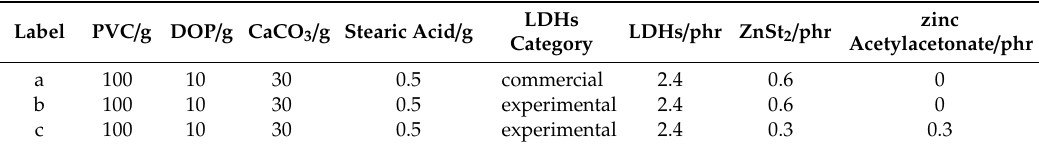
Table 4. Rheology test recipe of the samples.